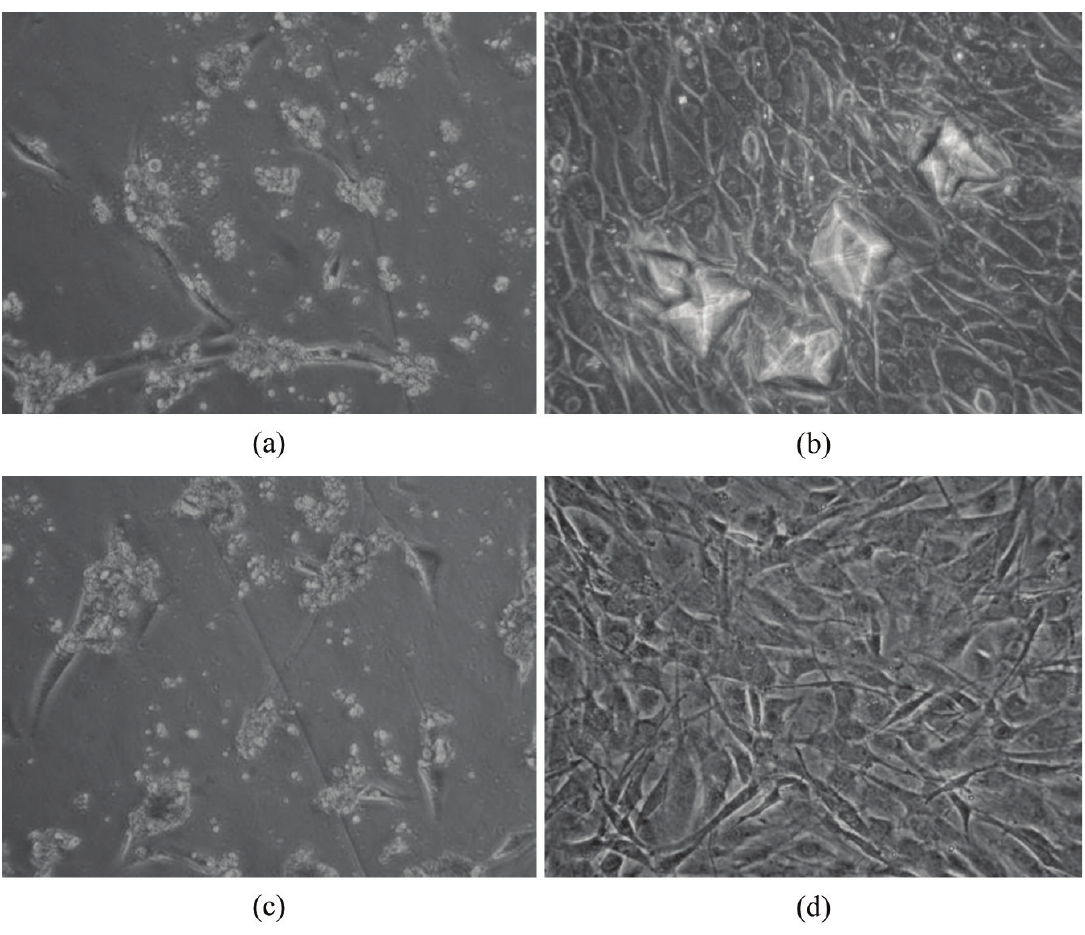
Figure 5. Phase contrast images (×200) of crystal forming ability of MC3T3-E1 cells cultured together with collagen microspheres encapsulating steroidal saponins (a,b) and pure-collagen microspheres (c,d) for 1 day (a,c) and 10 days (b,d), respectively.